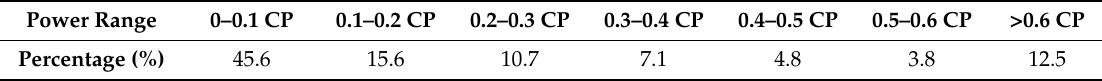
Table 5. Power distribution in UDDS and HWFET.